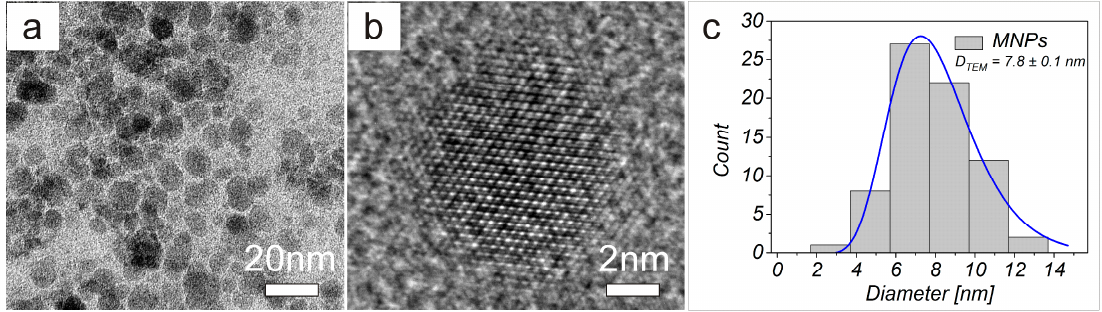
Figure 2. ( a ) TEM and ( b ) high resolution transmission electron microscope (HRTEM) images of MNPs. ( c ) TEM size distribution obtained from TEM images of MNPs.